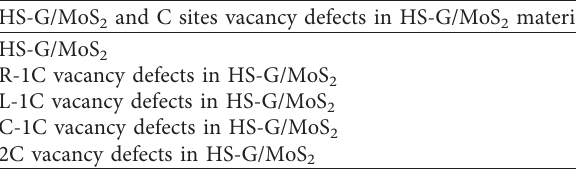
2 materials. (a) R-1C atom vacancy defects in